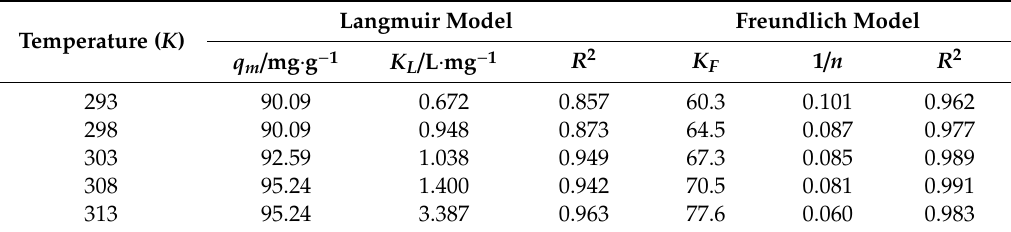
Table 4. Thermodynamic parameters at different temperatures.